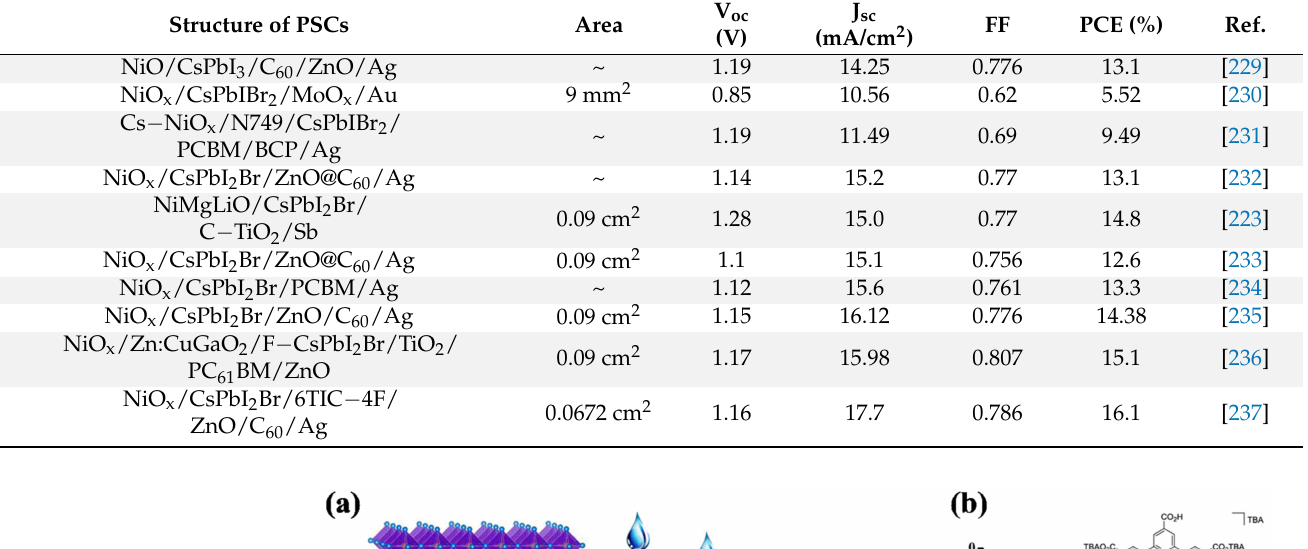
Table 20. Performances of several representative all − inorganic inverted PSCs.